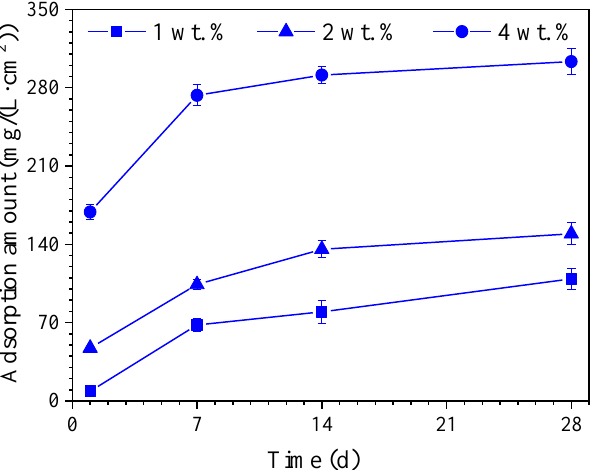
Figure 8. The adsorption amount of hydrophobic functional organic corrosion inhibitor on the surface of HPB235 carbon steel in SPS at different immersion ages.